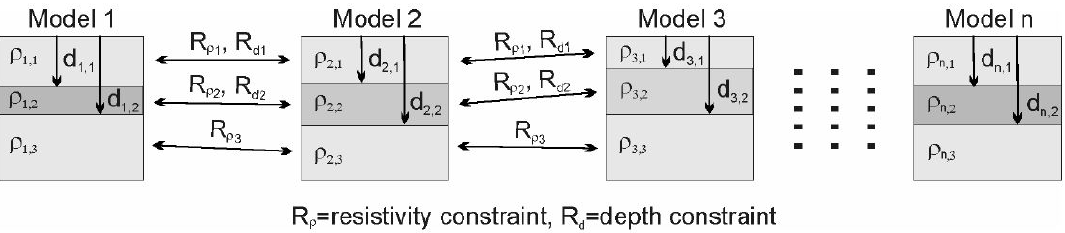
Figure 2. Diagram of laterally constrained inversion [38] .